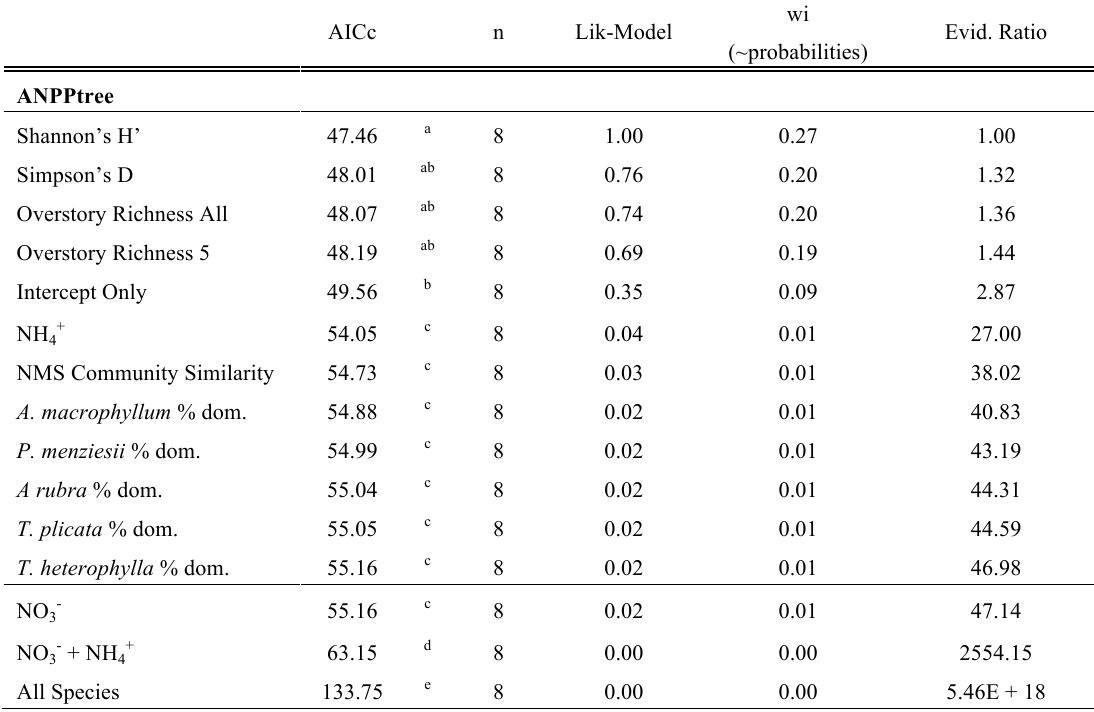
Table 4. Model selection ranking * for the best models predicting aboveground net primary productivity of trees (ANPP ) in plots where N data were also available. tree wi AICc n Evid.